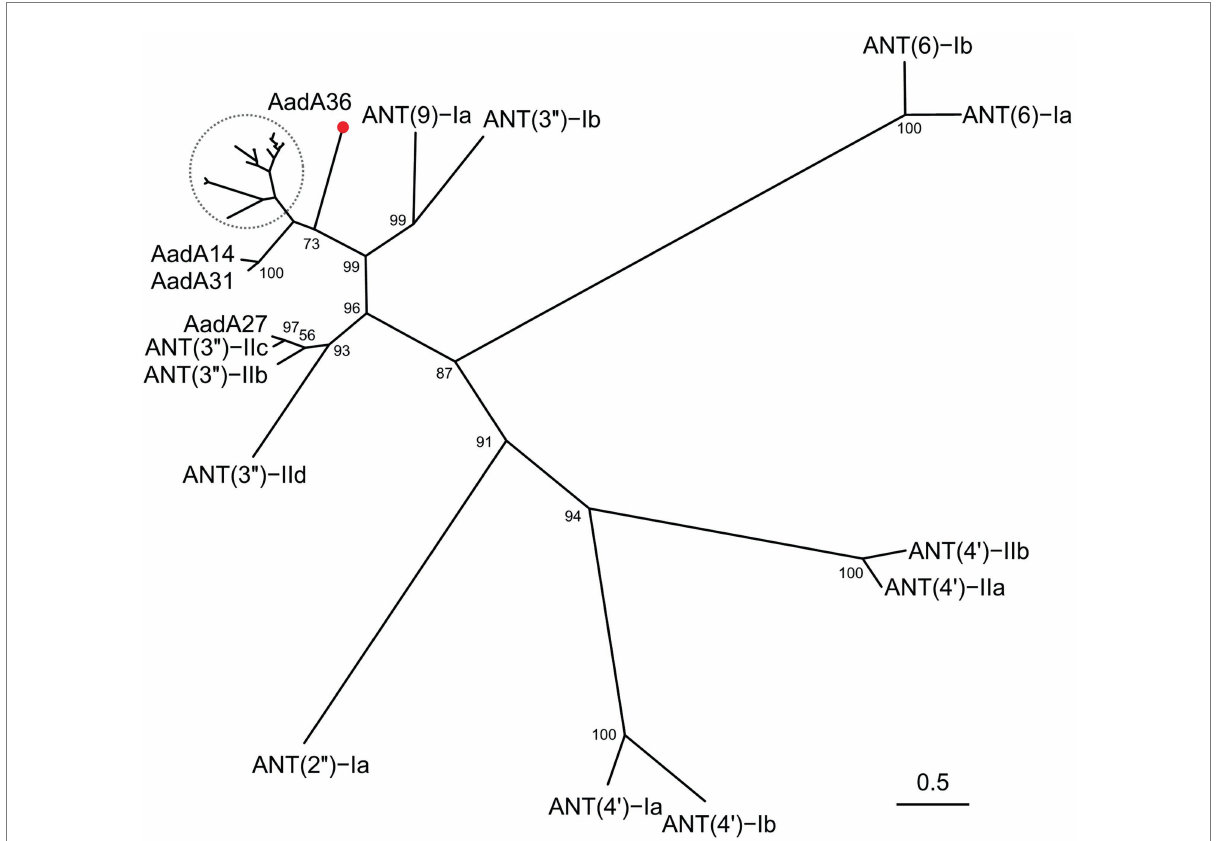
FIGURE 1 A phylogenetic tree showing the relationship of AadA36 with other functionally characterized aminoglycoside nucleotidyltransferases. AadA36 from our study is highlighted with a red dot. The dashed area includes AadA1, AadA4, AadA5, AadA6, AadA7, AadA8, AadA9, AadA10, AadA11, AadA13, AadA17, AadA21, AadA23, AadA24, AadA25, AadA28, AadA29, AadA30 and ANT (3 ″ )-IIa. Bootstrap values were displayed at the nodes.